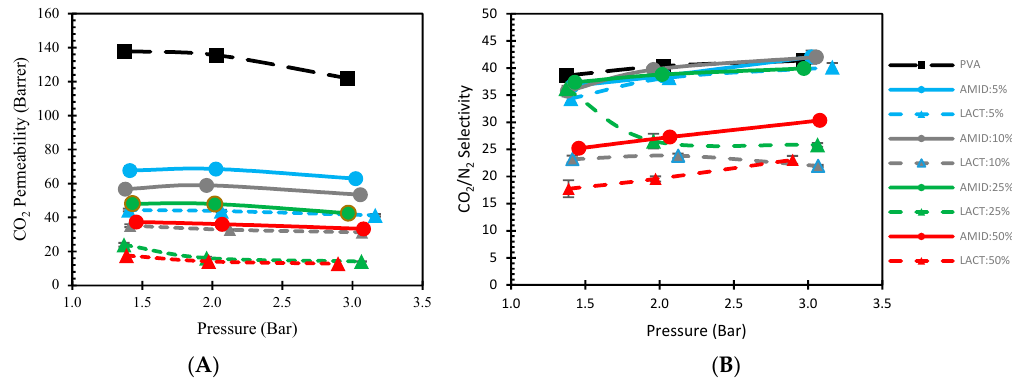
Figure 10. Effect of gas separation performance of nanocomposite membranes by the increment of pressure. Permeability ( A ); Selectivity ( B ). Amidino POSS ® /PVA (straight line), Lactamide POSS ® /PVA (dash line), PVA (black), 5% (blue), 10% (gray), 25% (green), 50% (red).